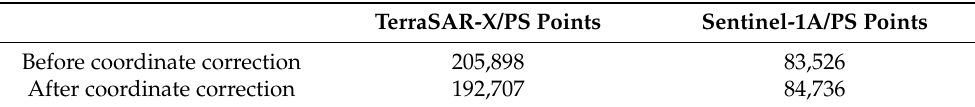
Table 4. Statistics of geometric correction results of building PS points.